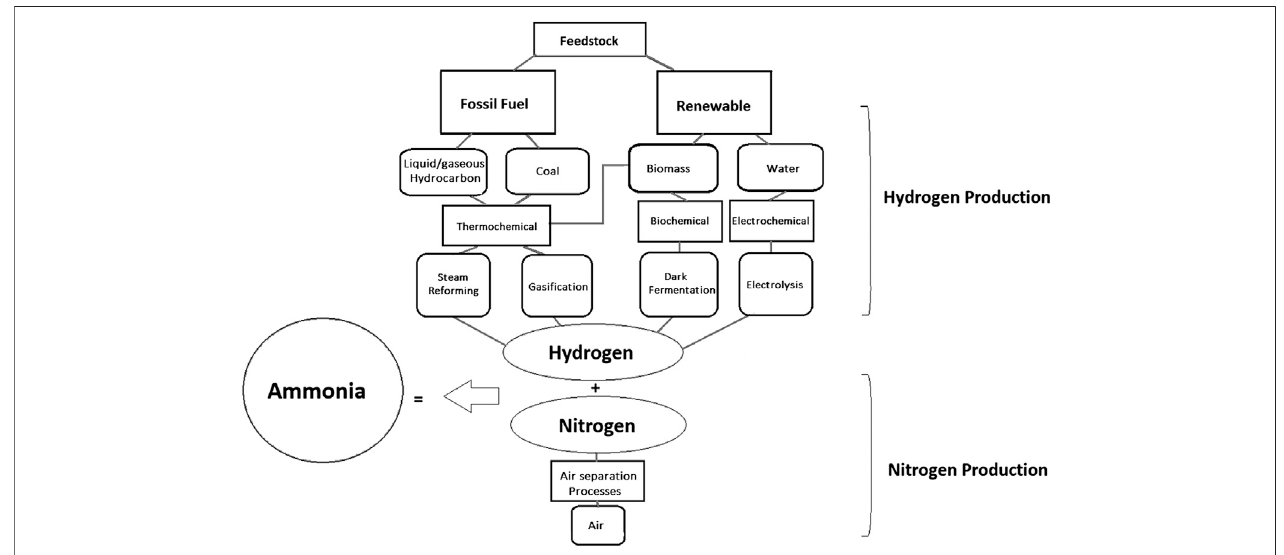
FIGURE 1 | Various hydrogen production